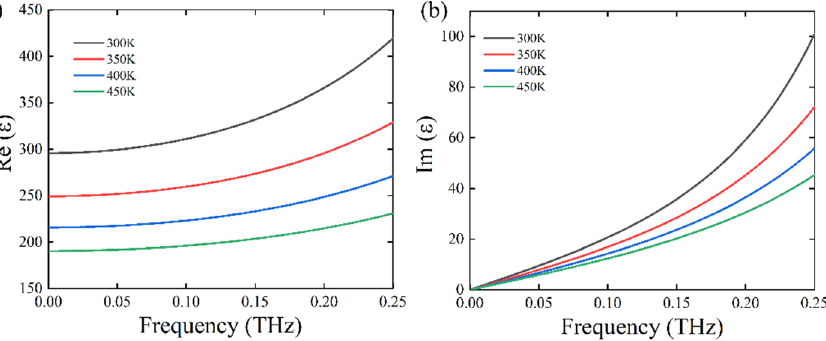
Figure 1. The calculated permittivity of STO under different temperatures. ( a ) Real part of permittivity of STO. ( b ) Imaginary part of permittivity of STO.